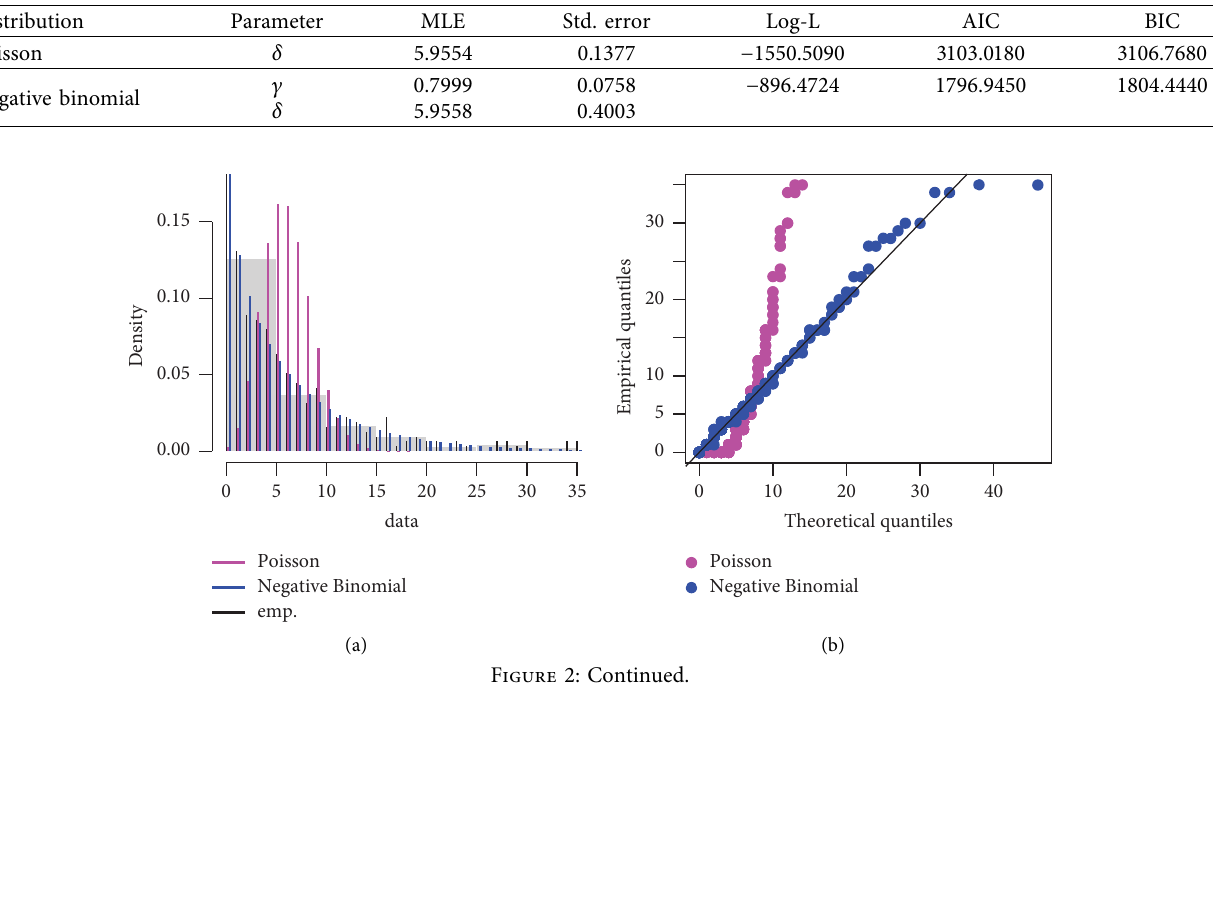
Figure 1: Histogram and density using the real data. Table 10: MLE, AIC, and BIC values of the real